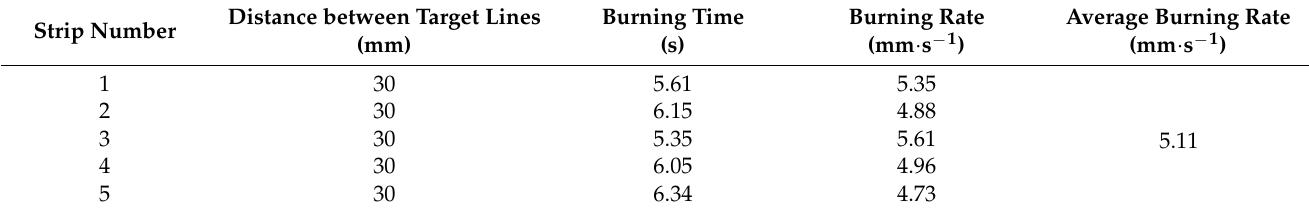
Table 6. Test results of the burning rate of the 3D-printed